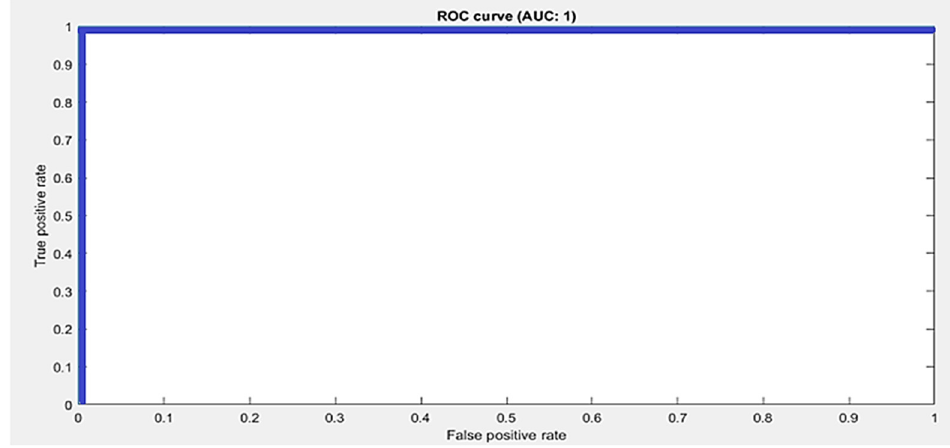
Figure 5. Macro average ROC curve and AUC score by the proposed approach using the Dexter dataset.